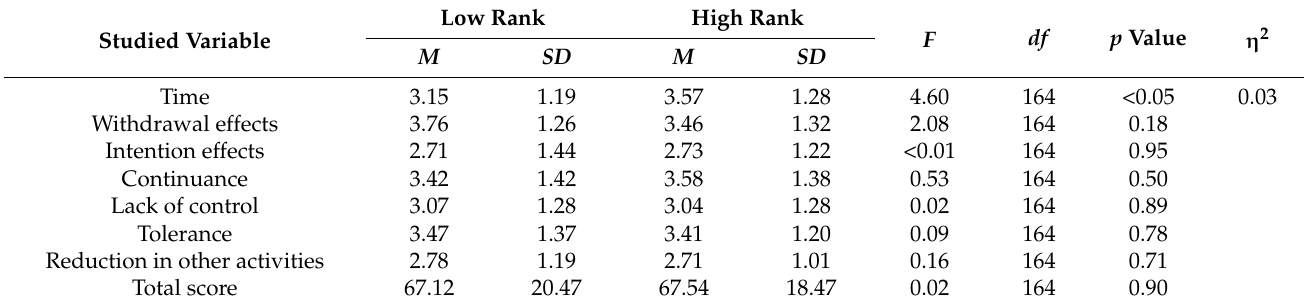
Table 4. Comparison of results by training rank of respondents.